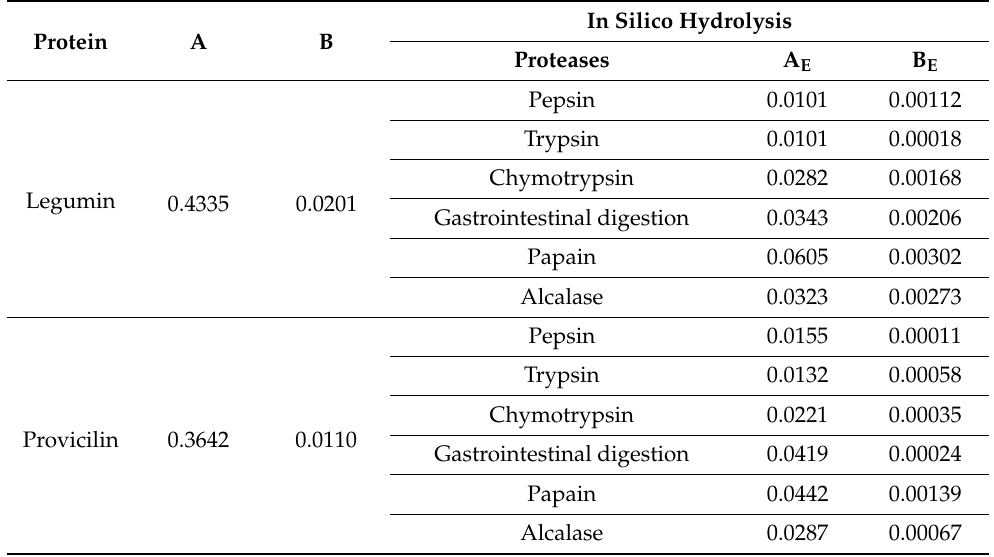
Table 1. ACE-I inhibitory predicted values of legumin and provicilin from chickpea ( Cicer arietinum L.).